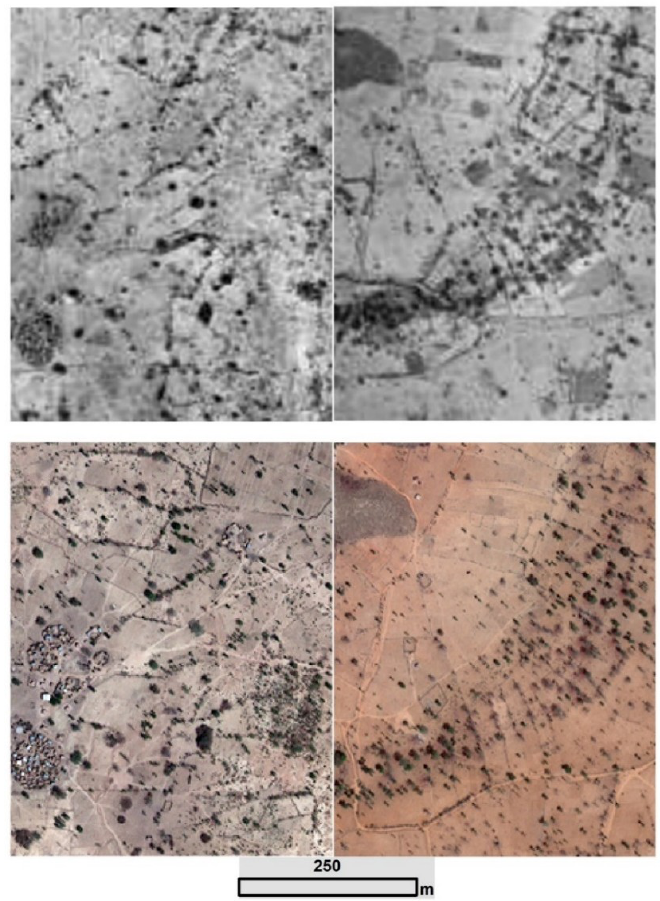
Figure 11. Comparison of 1992 aerial photos ( top ) with 2014 GeoEye satellite images for SWC-treated areas in Kouka ( left ) and Loulouka ( right ). Dams and contour stone bunds appear as faint straight lines in bottom panels.